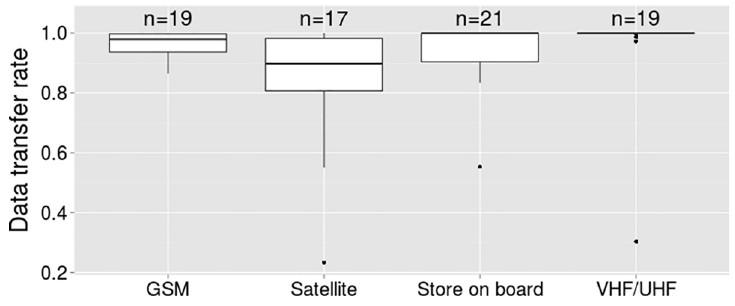
Fig 4. Data transfer success. Data transfer rate per main transfer method used in the